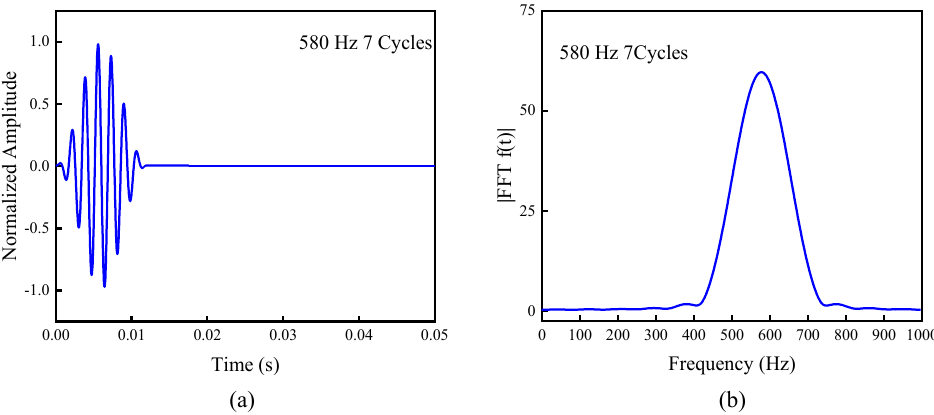
Figure 11. Three-dimensional full-scale finite periodic REM structure.